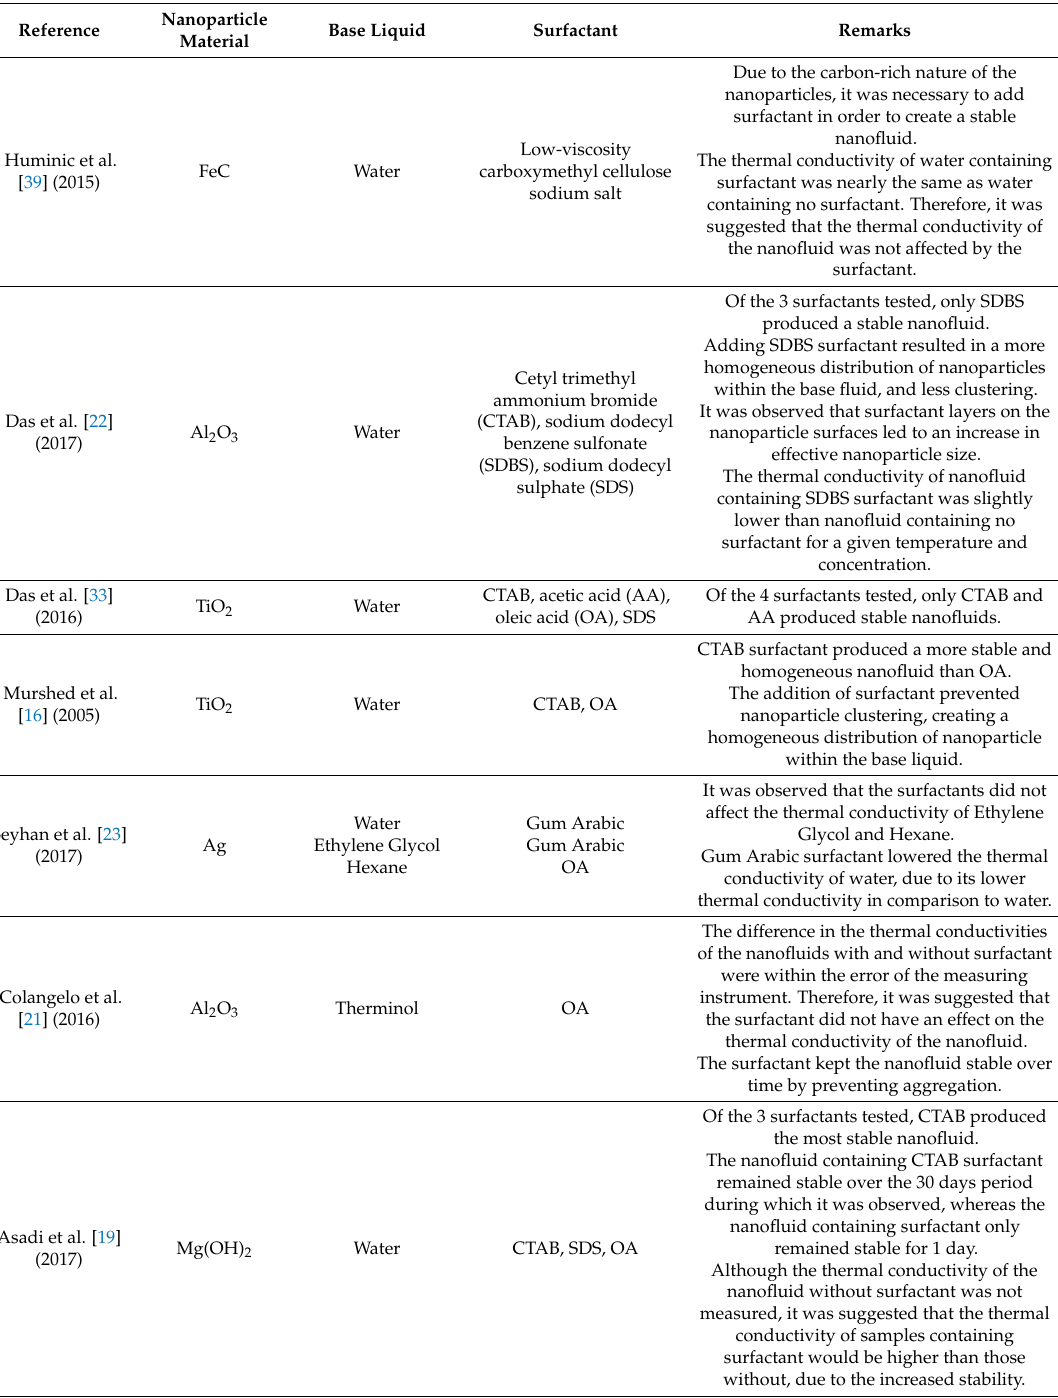
Table 3. Effects of surfactant on